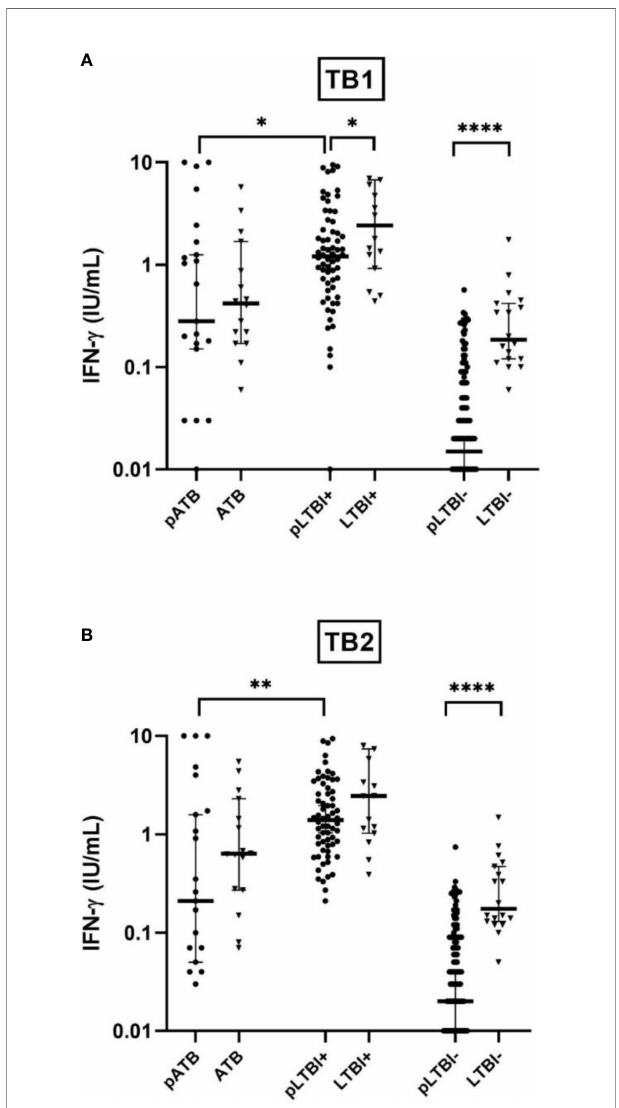
FIGURE 1 | Comparison of IFN- g production response by QuantiFERON-TB Gold-Plus Assay with stimulation with TB1 (A) and TB2 (B) antigens between pregnant women (pATB, pLTBI-, and pLTBI+) and their non-pregnant counterparts (ATB, LTBI-, and LTBI+). Symbols indicate individual IFN- g values for pregnant participants (black circles) and non-pregnant (black triangles). The solid lines indicate median and 95% CI. The Mann – Whitney U-test (two-tailed) comparison were calculated and shown as *p < 0.05, **p < 0.01, and ****p < 0.0001. pATB, TB-con fi rmed pregnant women; ATB, TB-con fi rmed non-pregnant women; pLTBI-, pregnant women with QFT-P negative response; pLTBI+, pregnant women with QFT-P positive response; LTBI-, healthy non-pregnant control with QFT-P negative response; LTBI+, healthy non-pregnant control with QFT-P positive